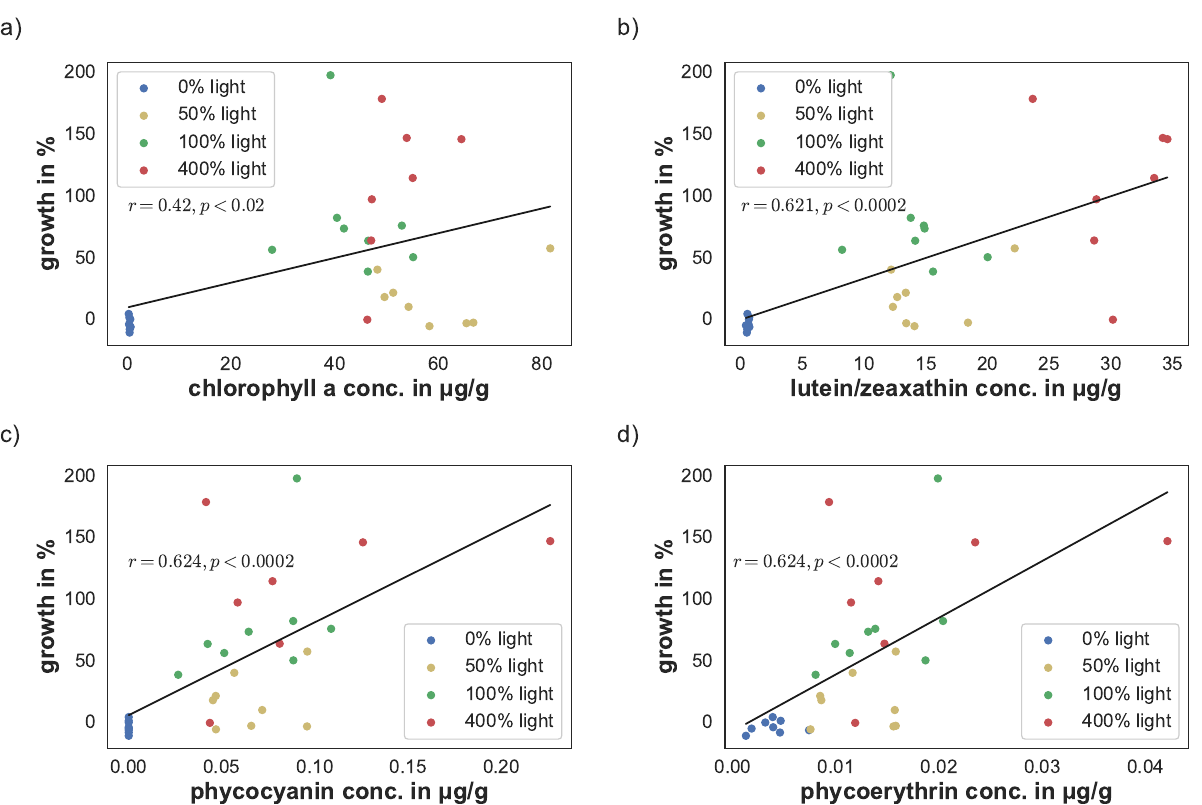
Figure 7. Correlation of pigment concentration and sponge growth for ( a ) chlorophyll a , ( b ) lutein/zeaxanthin, ( c ) phycocyanin, and ( d )